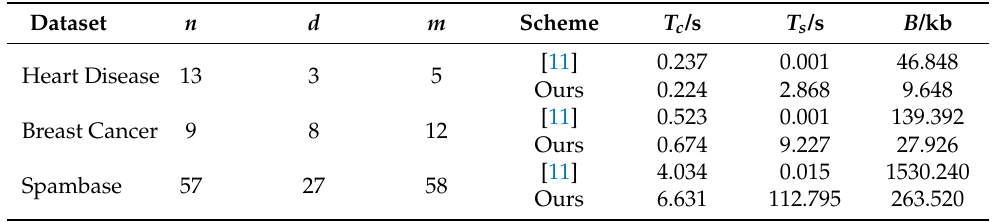
Table 4. Runtime and communication costs in real datasets for private decision-tree-evaluation protocols. The column “ n ” denotes the dimension of vector, “ d ” denotes the depth of the decision tree, and “ m ” denotes the number of decision nodes in the decision tree. These pieces of information represent the complexity of the decision tree. The column T s is the runtime of the server, and T c is the runtime of the client. Finally, B is the communication cost of